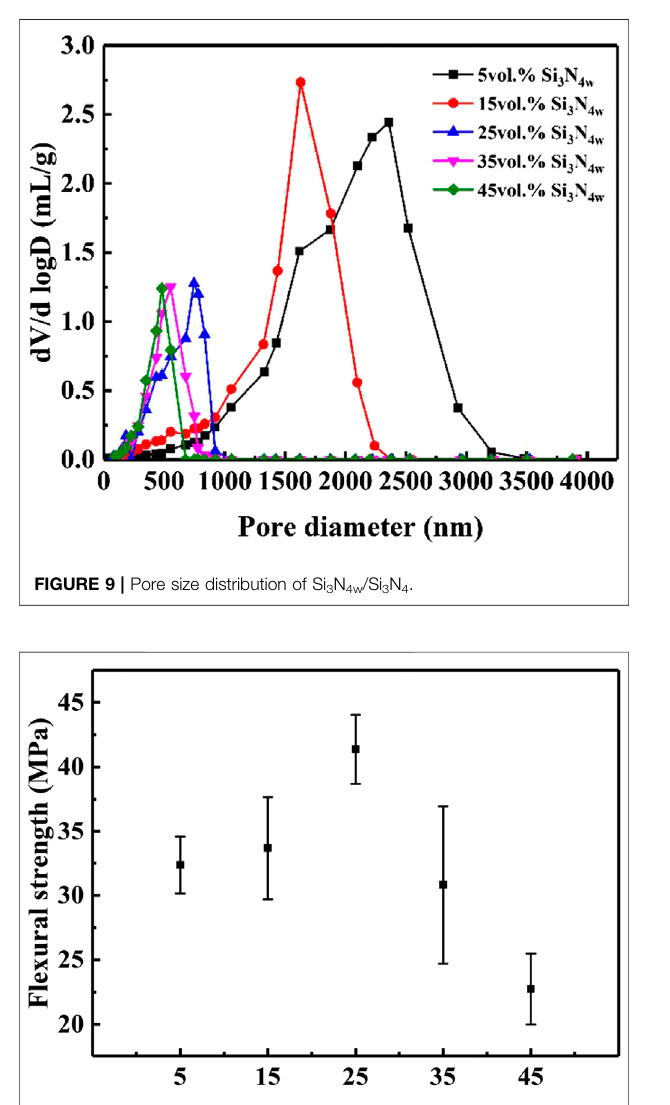
Frontiers in Materials |